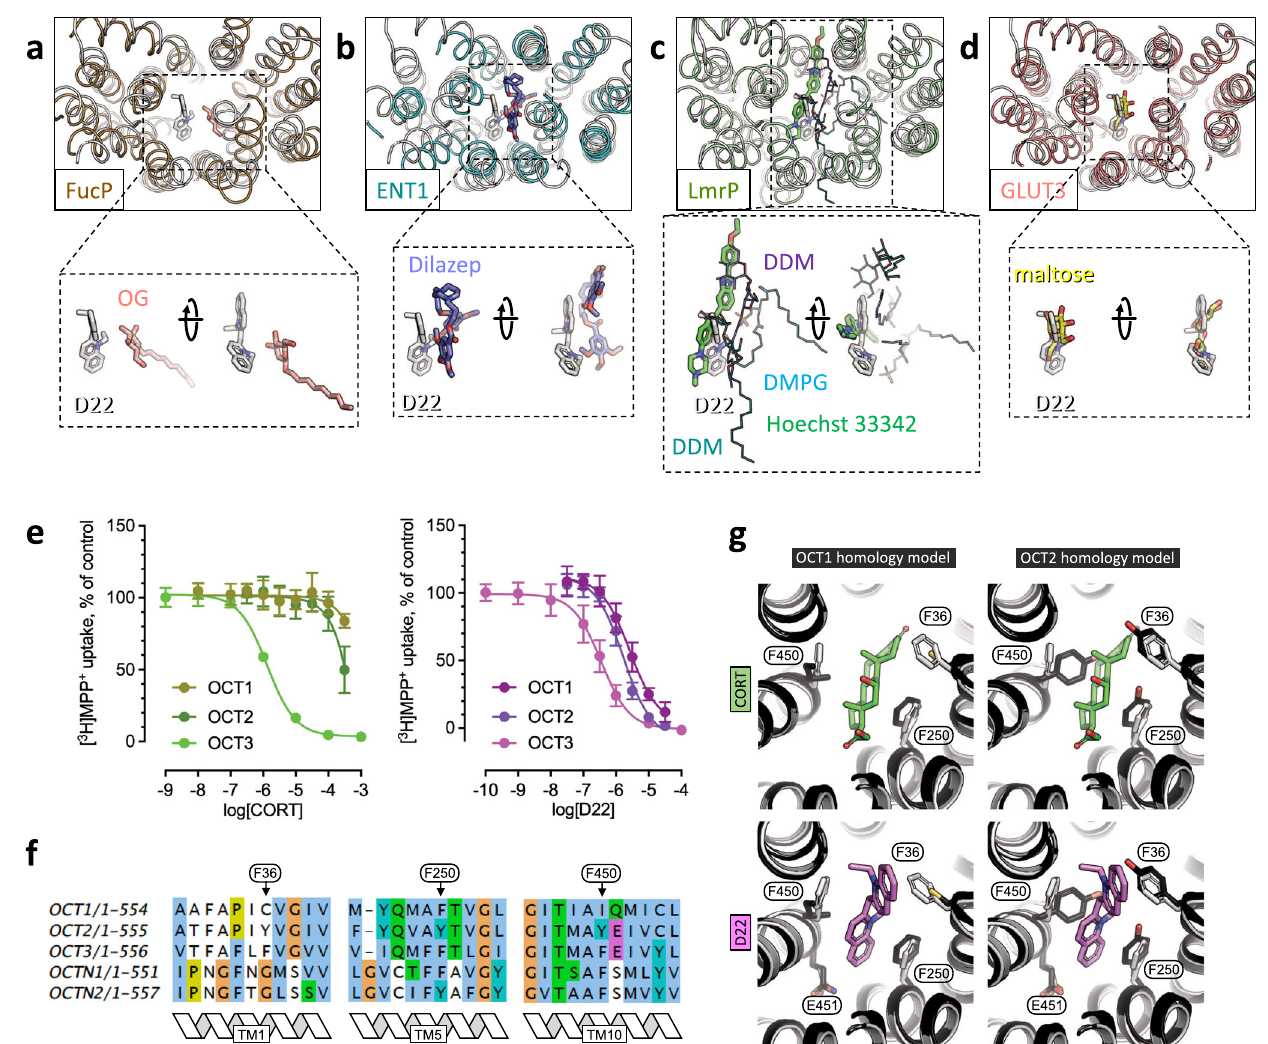
Fig. 3 | Molecular basis of OCT3 ligand speci fi city. a – d Comparison between OCT3-D22 and four different MFS transporter structures in outward-facing, ligand bound states, including FucP (PDB ID: 3o7q), ENT1 (PDB ID: 6ob7), LmrP (PDB ID: 6t1z)andGLUT3(PDBID:4zwc).Thedottedlines/boxesshowthezoomedinviews of the isolated ligands ( left , same orientation as in the main panel; right – rotated ~90°). e Inhibition of OCT1, 2 and 3 transport by D22 and CORT (mean±SD; n =3).